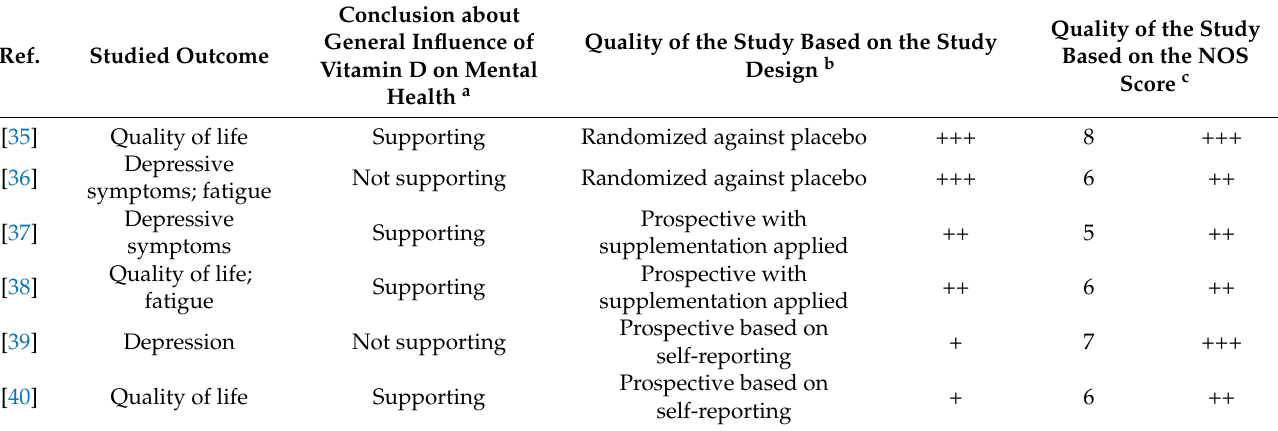
Table 6. The summary of conclusions from the studies of multiple sclerosis (MS) patients included in the systematic review accompanied by the assessment of the quality of studies based on the design of the studies and the Newcastle-Ottawa Scale (NOS)